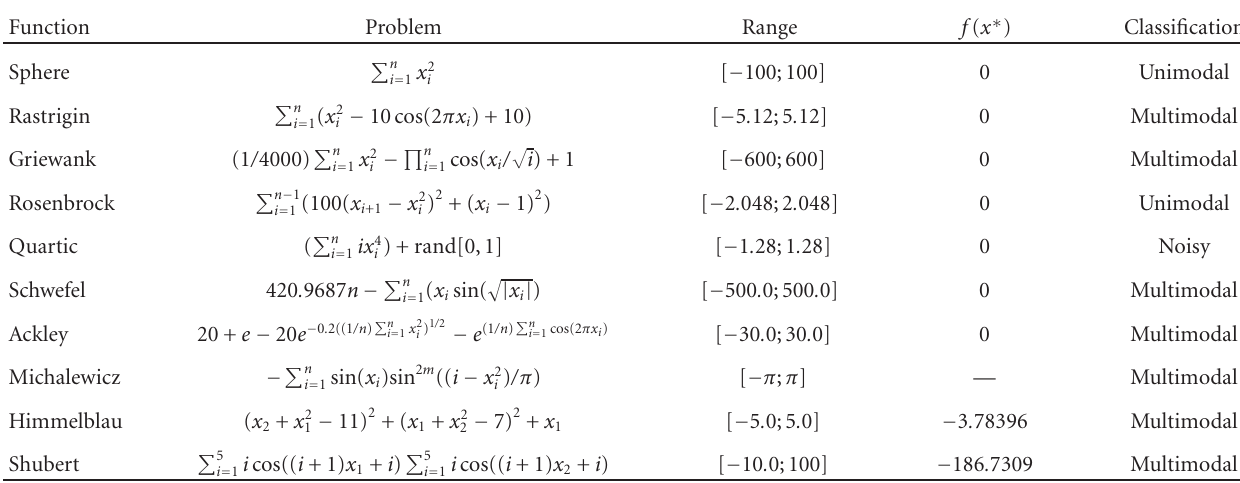
Table 1: Standard benchmark functions adopted in this work.